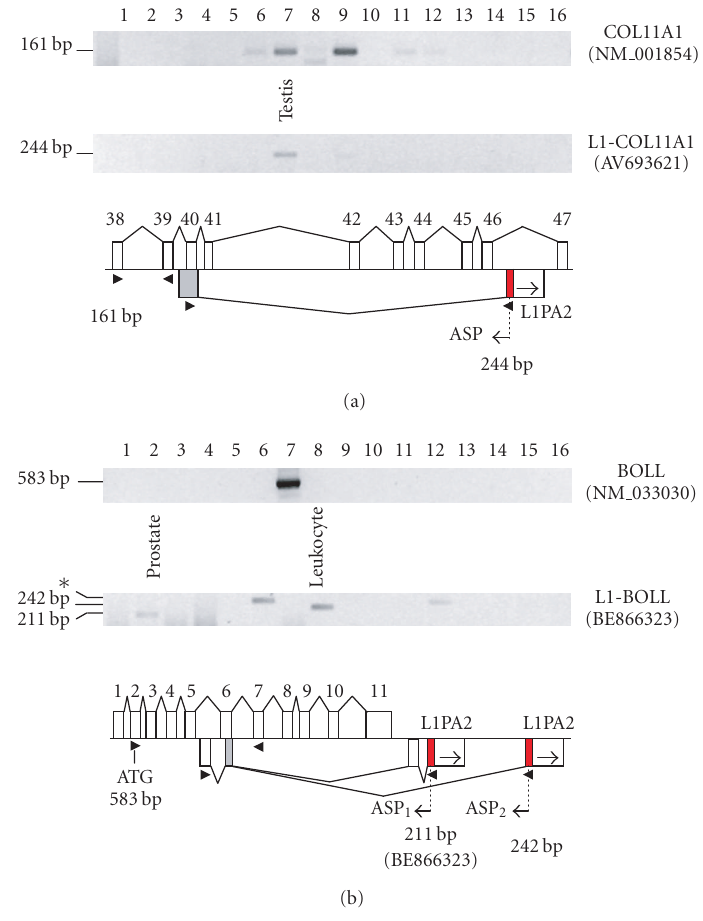
Figure 2: Distribution of antisense RNAs derived from L1 ASP. The presence of mRNAs derived from (a) COL11A1 [27], (b) BOLL [28], and their antisense RNAs is shown at the upper and lower RT-PCR panels, respectively. The exons of antisense RNAs L1- COL11A1 and L1- BOLL complementary to exon 40 of COL11A1 and exon 6 of BOLL are shown as grey boxes. (a) COL11A1 exons 38–47. (b) Two L1- BOLL splice variants and a nonspecific product, marked by an asterisk, are presented. A 211 bp product derived from the L1 ASP 1 is identical to EST BE866323 (splicing scheme III). A novel 242 bp product generated from the L1 ASP 2 corresponds to the splicing scheme V. For the remaining description details, see Figure 1